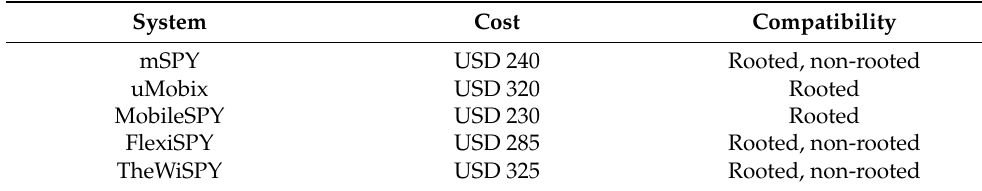
Table 3. Spyware applications adopted in this